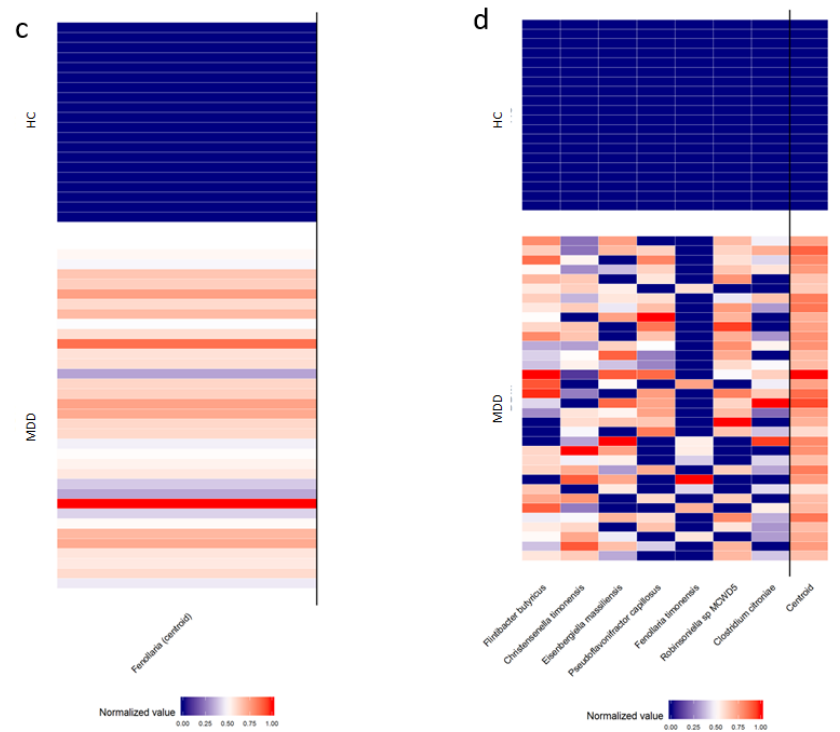
Figure 2. Heatmaps of relative abundance of bacterial populations (normalized Z-scores) identified by the penalized logistic regression analysis algorithm, at phylum ( a ) family ( b ), genus ( c ) and species ( d ) levels grouped by patients with major depressive disorder (MDD) and healthy controls (HC). Abbreviation (rev): the sign of the specific bacterial’s normalized value was reversed. Biomedicines 2020 , 8 , x FOR PEER REVIEW In Figure 3 the distribution of centroid Z-scores computed by PELORA in MDD patients and HC shows that the identified bacterial patterns were able to discriminate between the two groups, with a higher discriminatory power at family, genus and species levels.